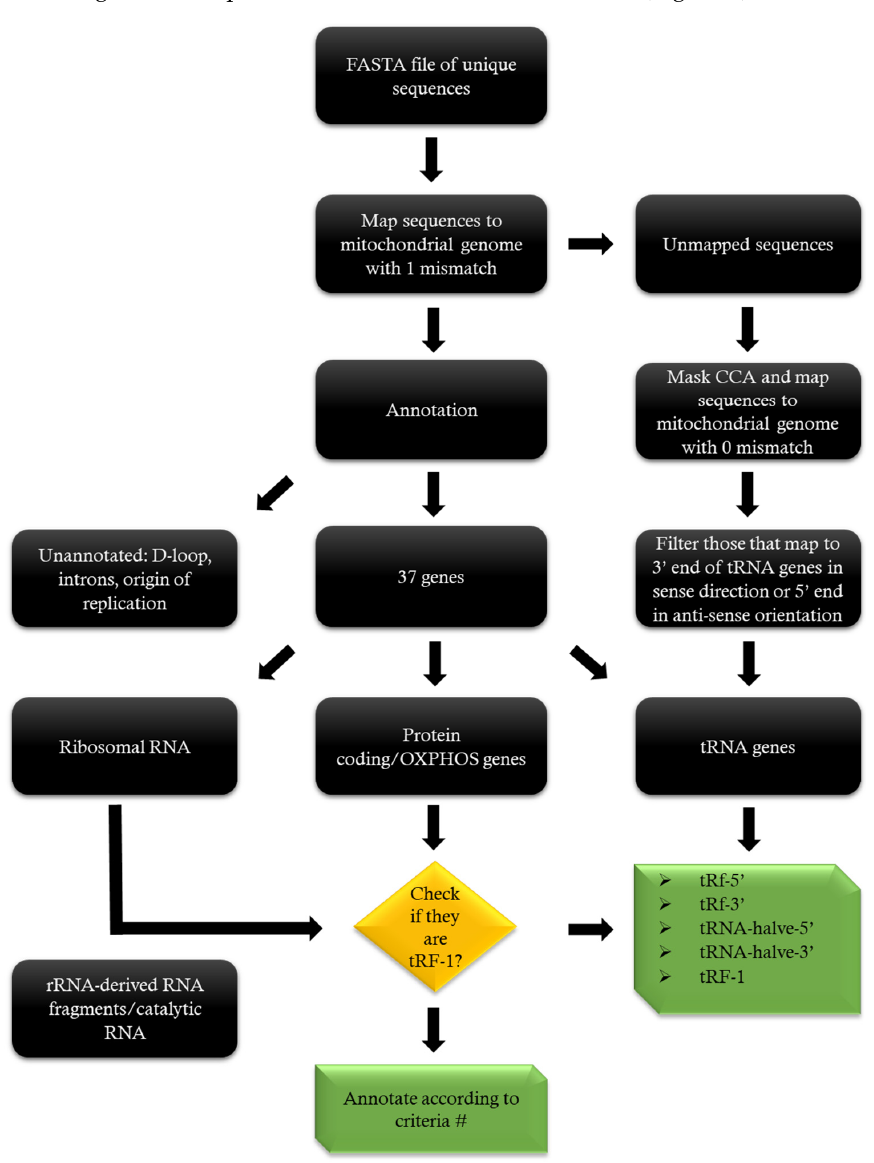
Figure 2. Workflow of mapping and annotation of mt-sRNA. # Annotation criteria: please see Supplementary File S8, Table S3.